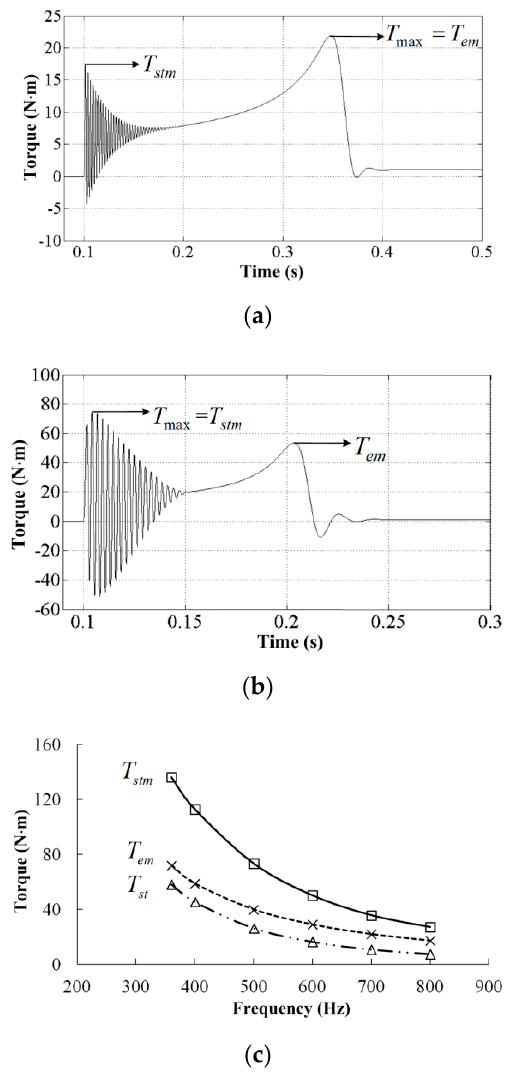
Figure 2. Starting peak torque of asynchronous motor. ( a ) Starting process of constant frequency asynchronous motor. ( b ) Starting process of variable frequency asynchronous motor. ( c ) The relationship between the starting pulse vibration torque and the power supply frequency.